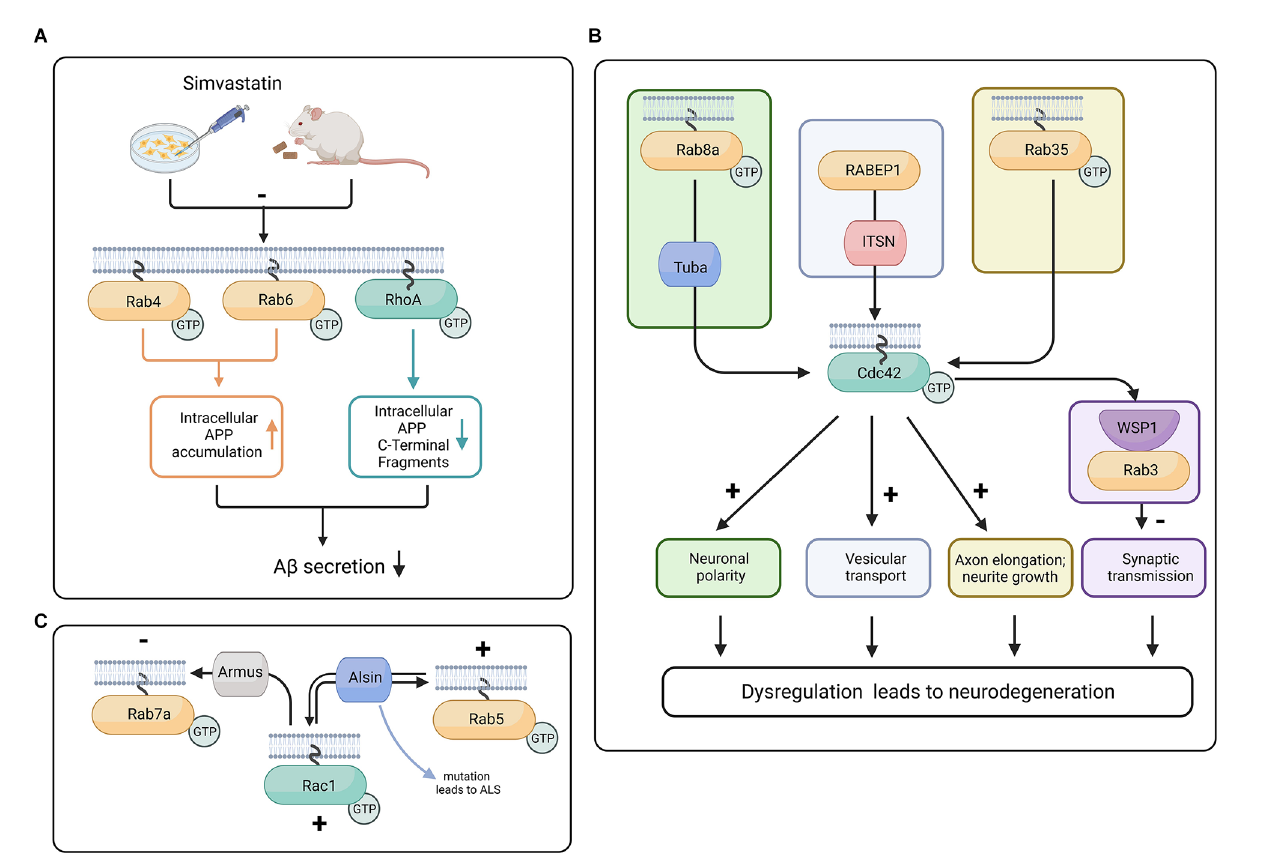
FIGURE3 Proposed crosstalk between Rab and Rho GTPases in progression of neurodegeneration. (A) In mouse and N2a cells, the treatment with Simvastatin reducesisoprenylationofRhoA,Rab4,andRab6.TheinhibitionofisoprenylationofRhoandRabproteinscan potentially reduceA β